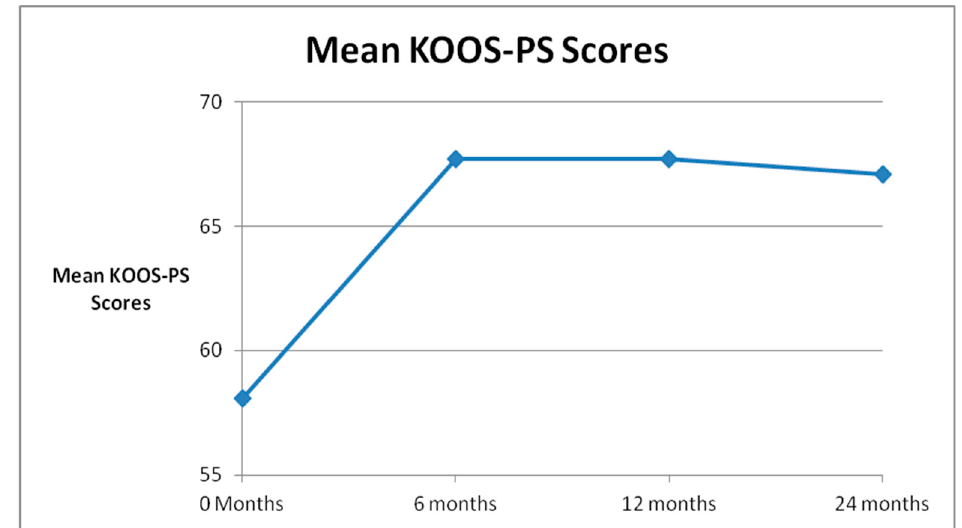
Figure 2. Single Assessment Numeric Evaluation (SANE) Scores.